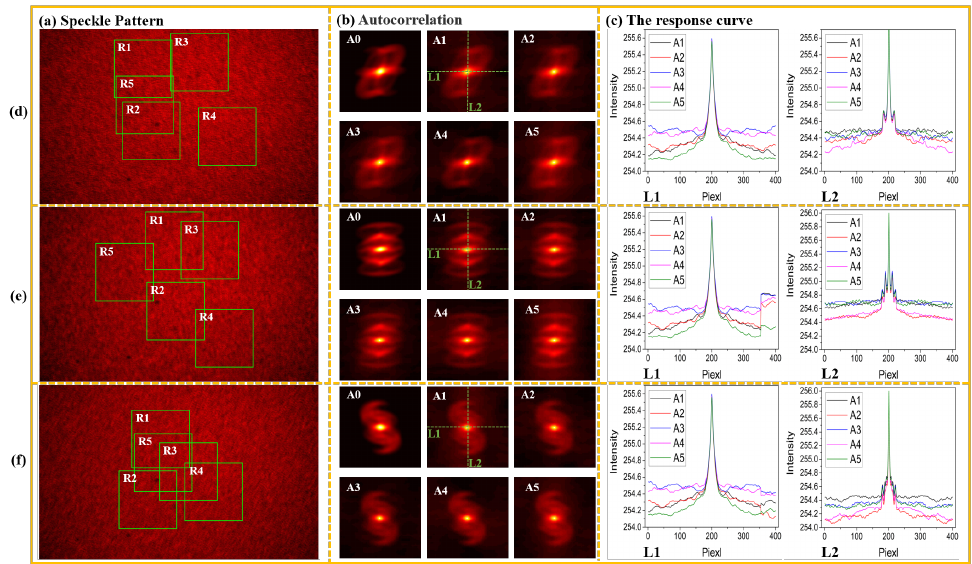
Figure 3. Comparison of speckle redundancy. ( a ) Original speckle pattern, R1 to R5 are the position of five subspeckle. ( b ) A0 is the autocorrelation of the GT corresponding to ( a ), A1 to A5 is the autocorrelation of speckles at the corresponding positions at R1 to R5. ( c ) The left and right curves are the gray values at direction of L1 and L2 on A1 to A5 respectively. ( d – f ) shows speckles corresponding to three different